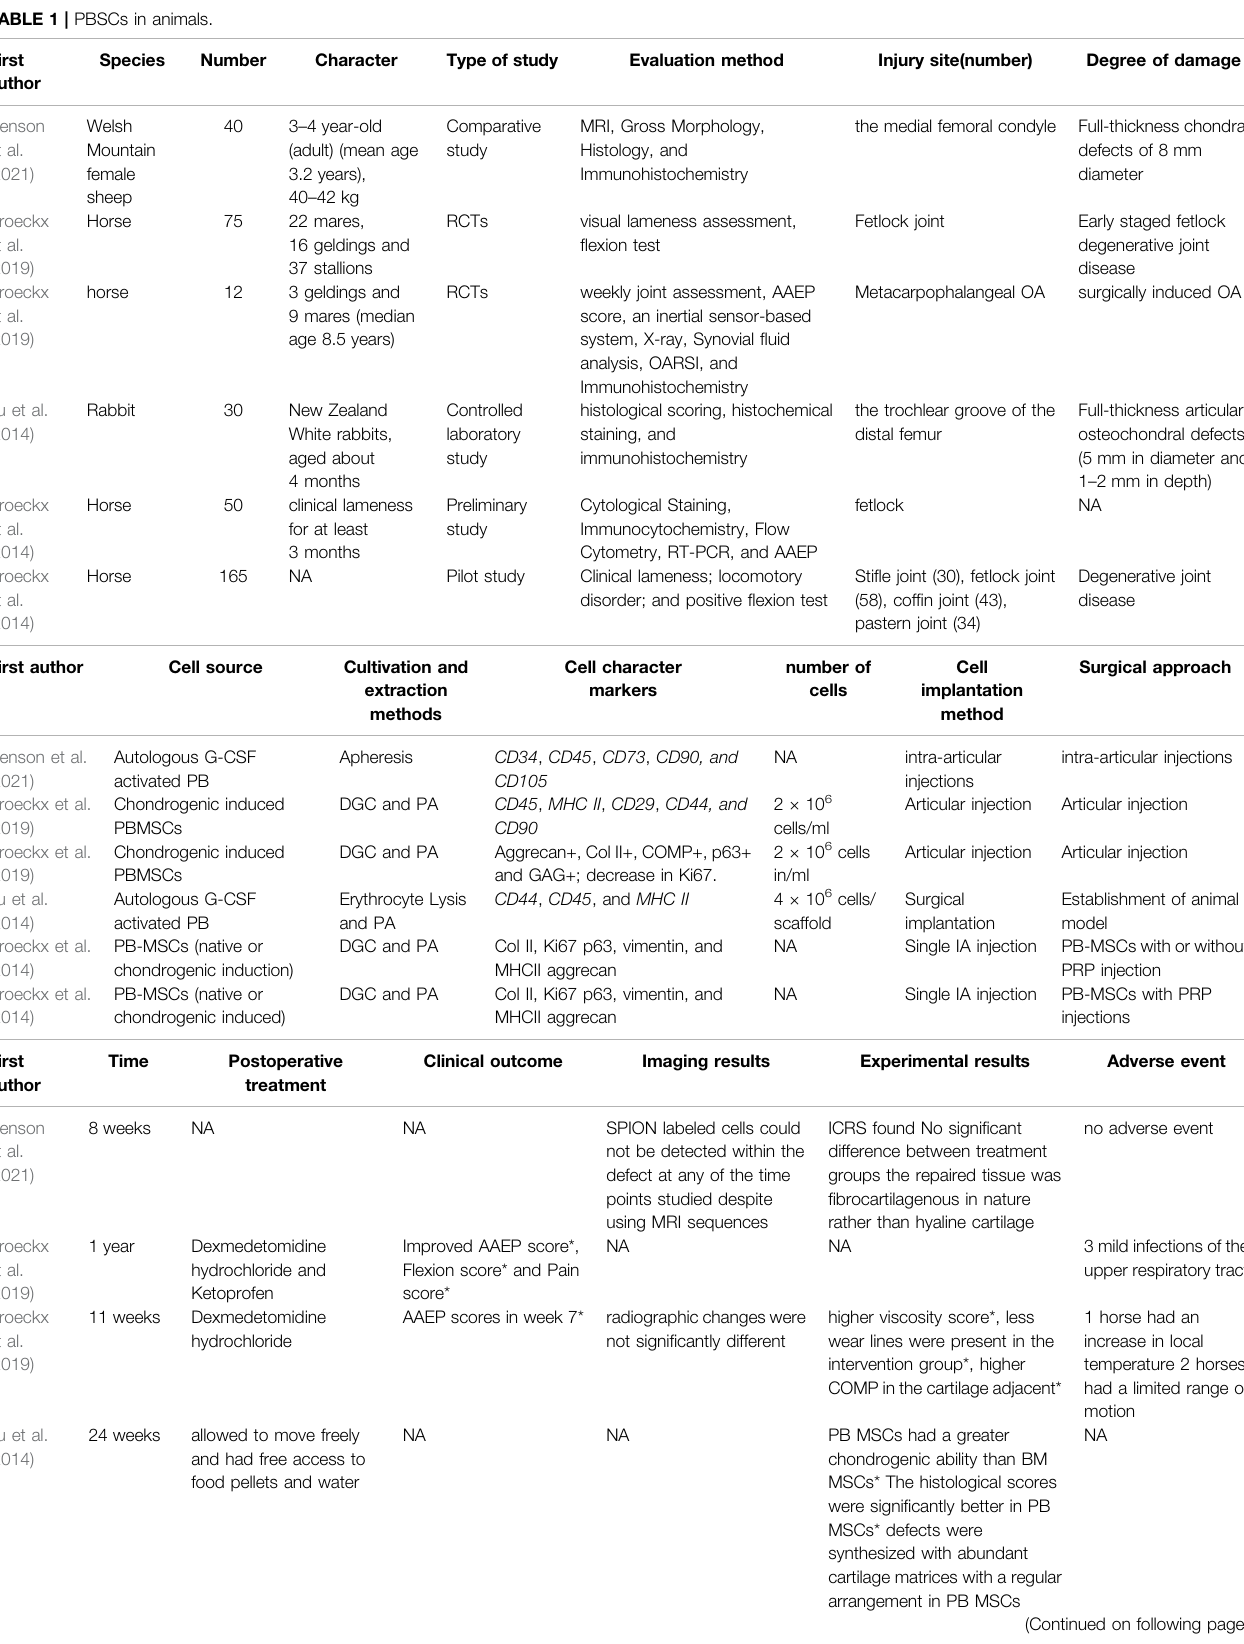
TABLE 1 | PBSCs in